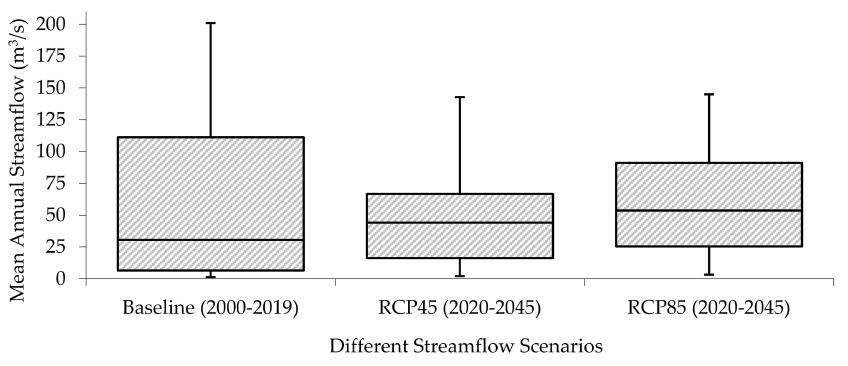
Figure 9. Mean annual variation in the streamflow under changing climate.